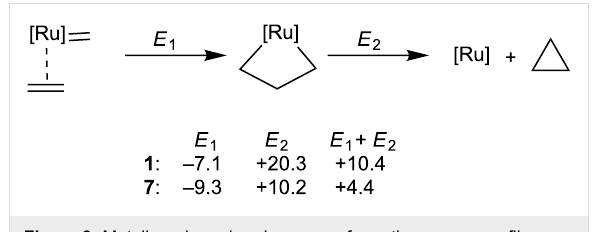
Figure 8: Metallocycle and cyclopropane formation energy profile (energies in